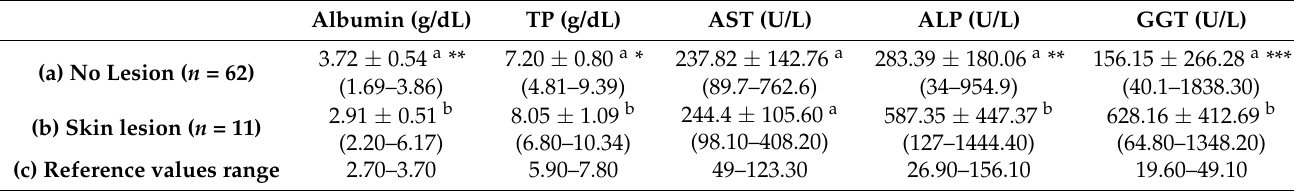
Table 2. Serum liver enzymes in sheep with and without cutaneous lesions 6 months after the onset of the facial eczema (FE) outbreak. Different superscripts between columns shown significant differences between the animal groups compared (* p < 0.05; ** p < 0.01; *** p < 0.001).